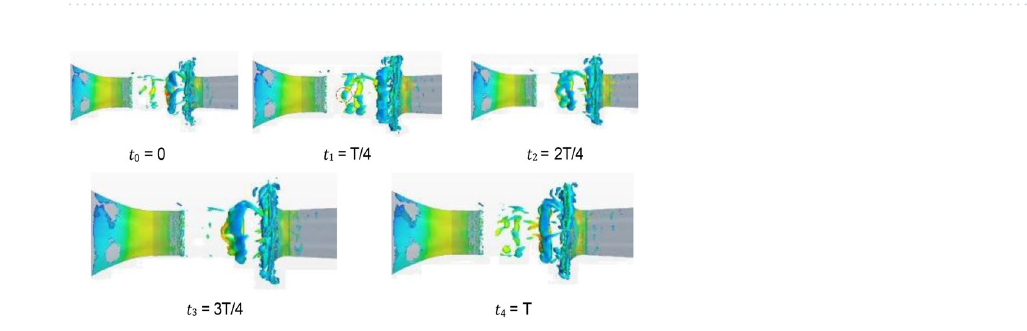
Figure 24. h80n12r50 simulation results.